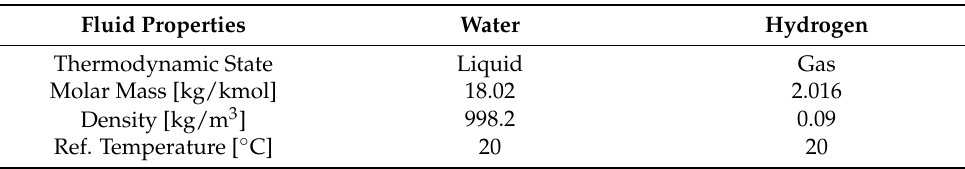
Table 2. Material properties of the water liquid and the hydrogen